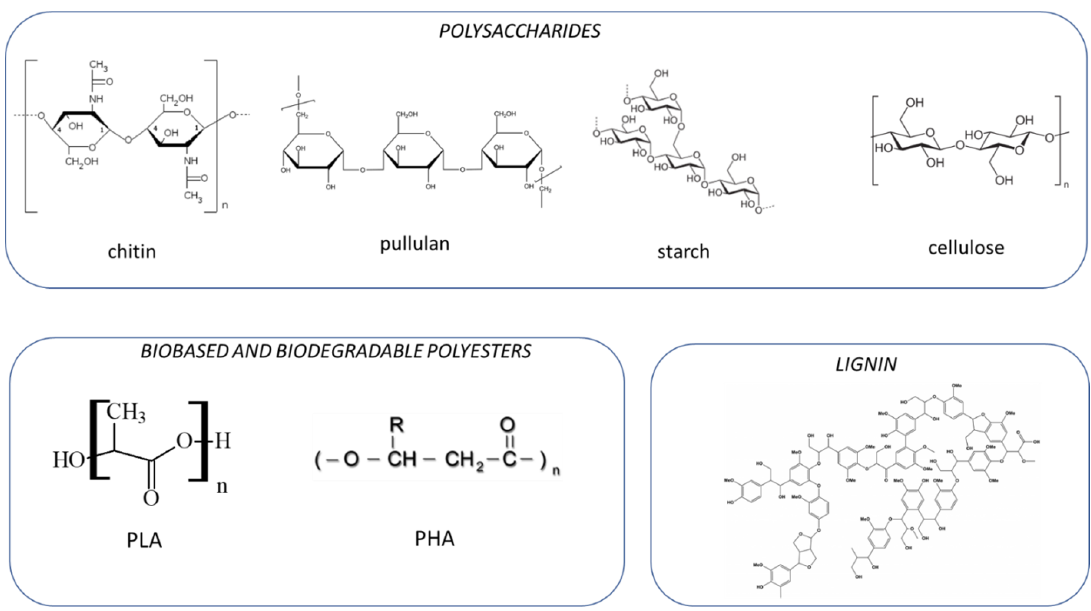
Figure 6. Biopolymers considered for producing a surgical face mask (SFM) and a beauty face mask (BFM) .